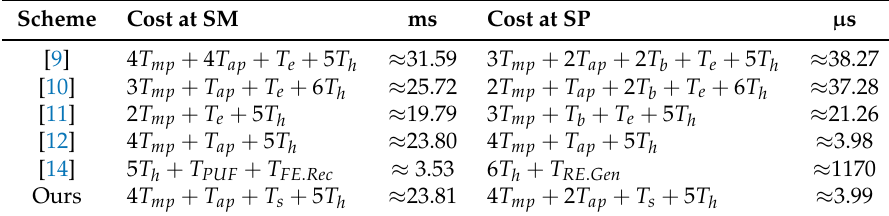
Table 3. Comparison of computational complexity among other schemes.